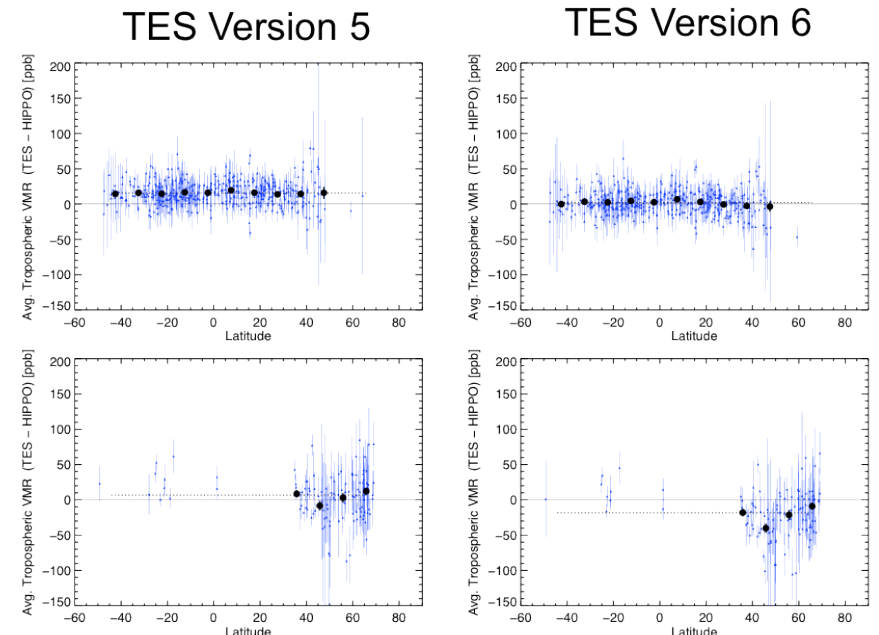
Figure 10. Latitudinal profiles of the differences between average tropospheric volume mixing ratios (VMRs) of the N 2 O- and global bias- corrected TES CH 4 retrievals and HIPPO CH 4 measurements for all five HIPPO campaigns. The average tropospheric VMR is calculated as the mean of the VMRs on the TES retrieval grid between 900hPa and the tropopause. The left column has the results for TES Version 5, and the right column has the results for TES Version 6. The top panel of each column shows the results for TES retrievals where the degrees of freedom for signal (DOFS) is ≥ 1 . 6. The bottom panel shows the results in scenes where the DOFS is < 1 . 6. The blue triangles are the differences for the individual TES retrievals, with blue lines showing the estimated retrieval error. The black circles show the mean bias for the scans binned by 10 ◦ latitude, while the black error bars are the standard deviation in each bin. Circles are only plotted when at least 10 scans are in a